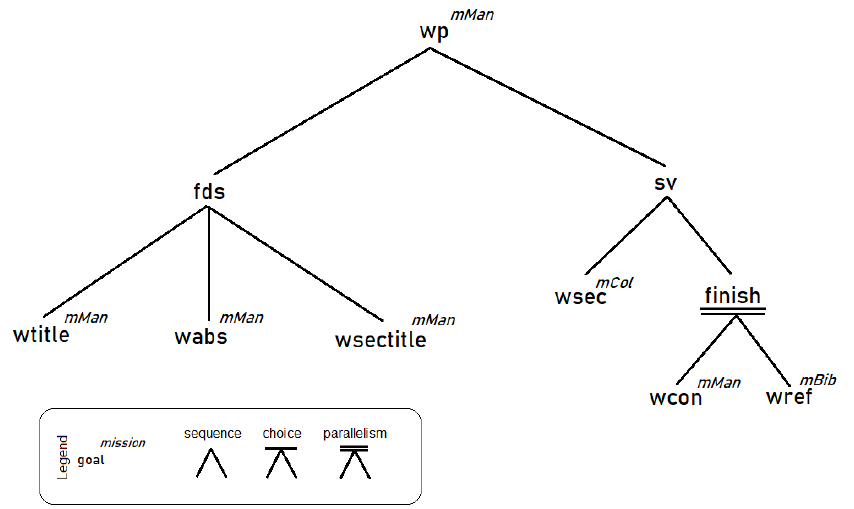
Figure 13. Functional specification for a Writing Paper scenario, adapted from